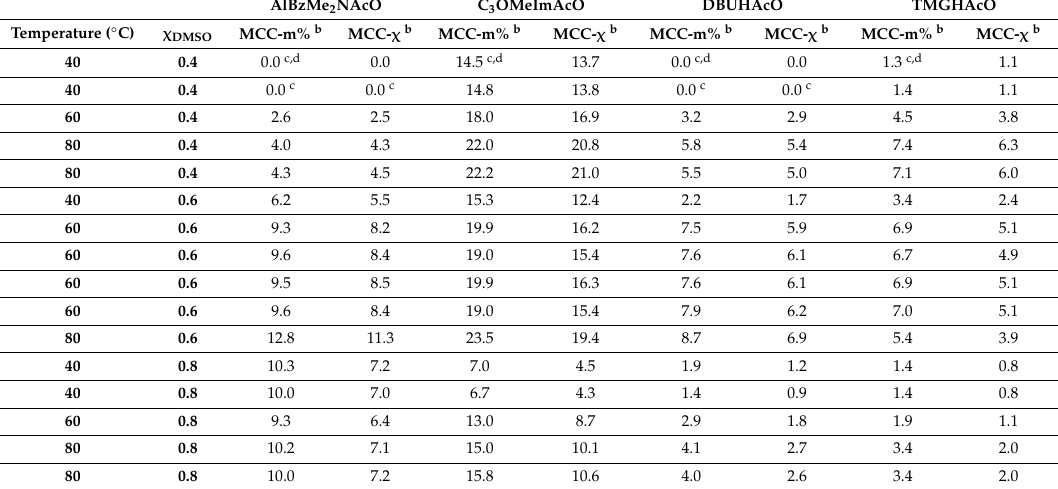
Table 1. Dependence of the dissolution of microcrystalline cellulose (MCC) in IL / DMSO binary mixtures on the molecular structure of the IL, the temperature, and the mole fraction of DMSO in the starting binary solvent a . AlBzMe 2 NAcO C 3 OMeImAcO Temperature ( ◦